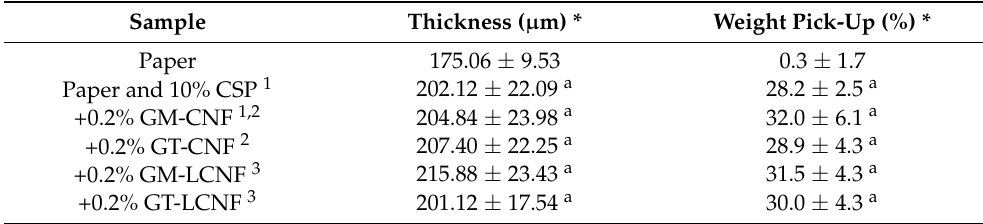
Table 1. Physical properties of paper samples treated with cottonseed protein and nanocellulose formulations.